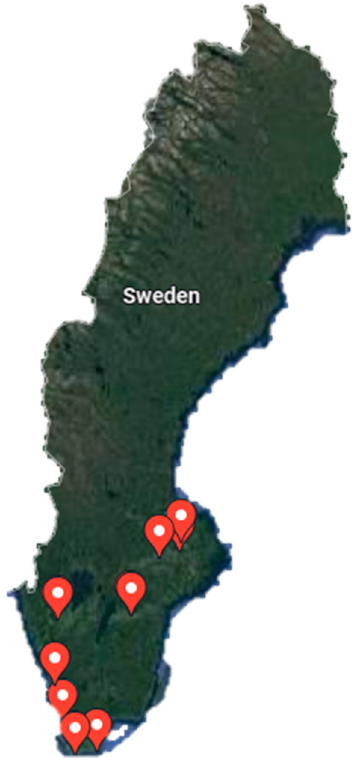
Figure 7. Map showing experimental trial locations in Sweden (Courtesy source from Google Maps 2022 (Google, accessed on 12 September 2022)). The red sign posts in the map indicates the geographical location of evaluated environments.